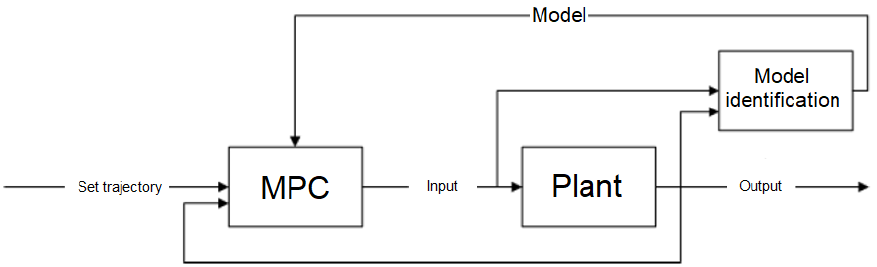
Figure 7. Structure of a QDMC controller with RLS model estimation.